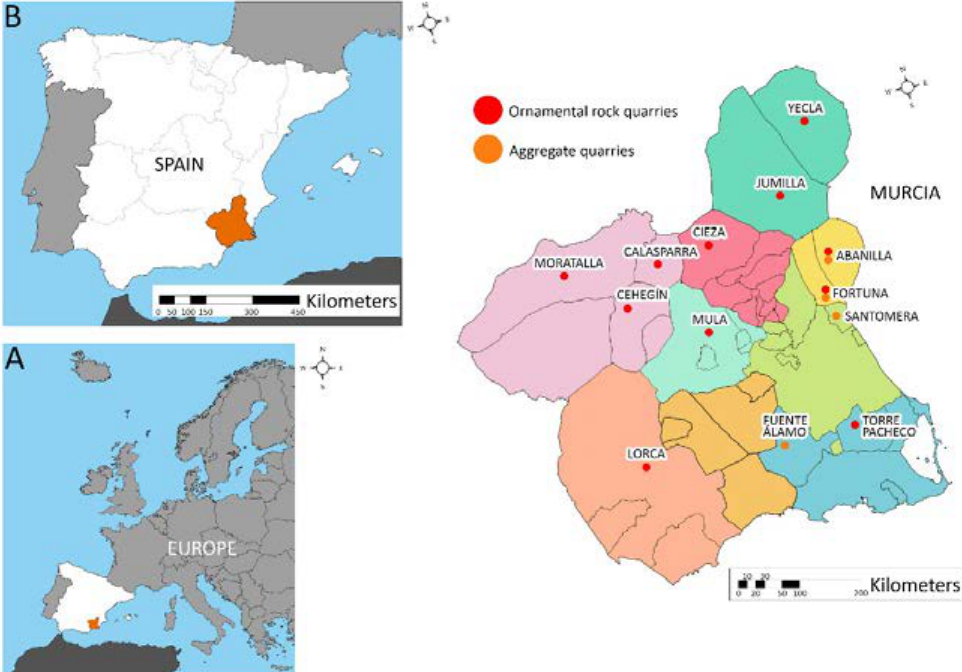
Fig. 1: Geographic location of the study area in the most representative municipalities in the Murcia region of Spain with ornamental rock and aggregate quarries